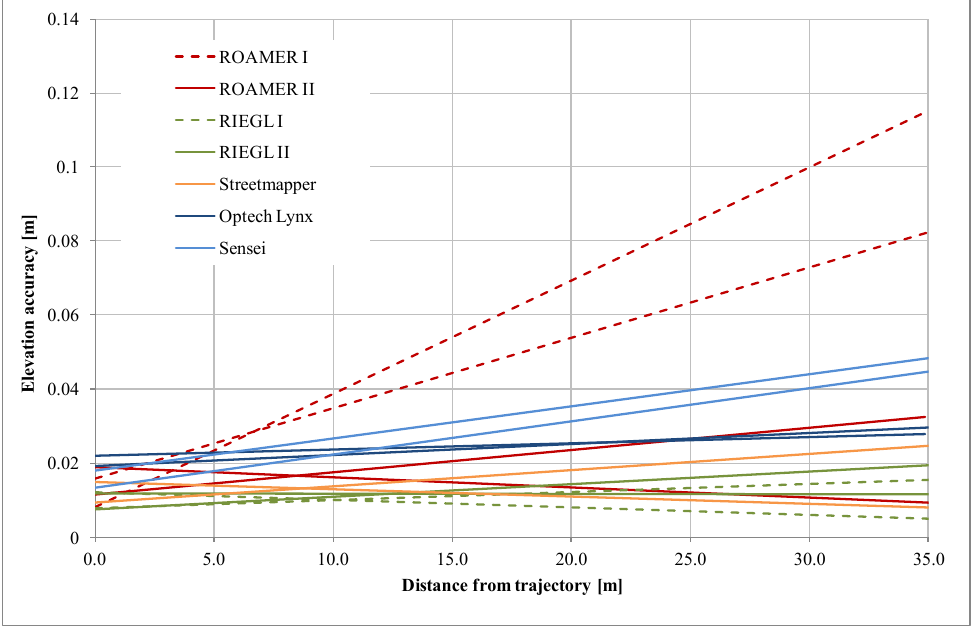
Figure 16. Elevation accuracy as a function of distance from the trajectory; with linear trend lines fitted to the observed errors in the two driving directions.